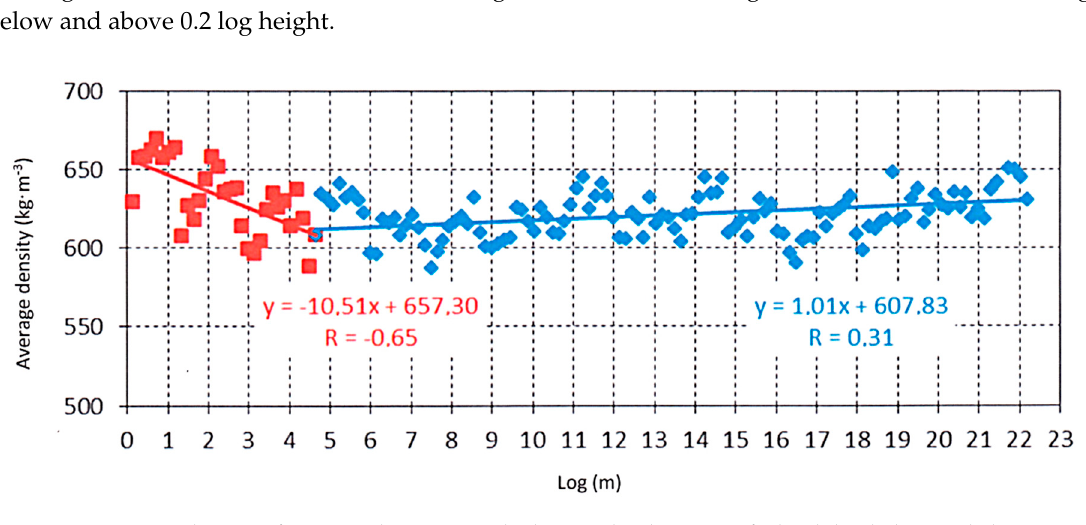
Figure 8. Distribution of average densities on the longitudinal section of a birch log below and above 0.2 log 0.2 log height.